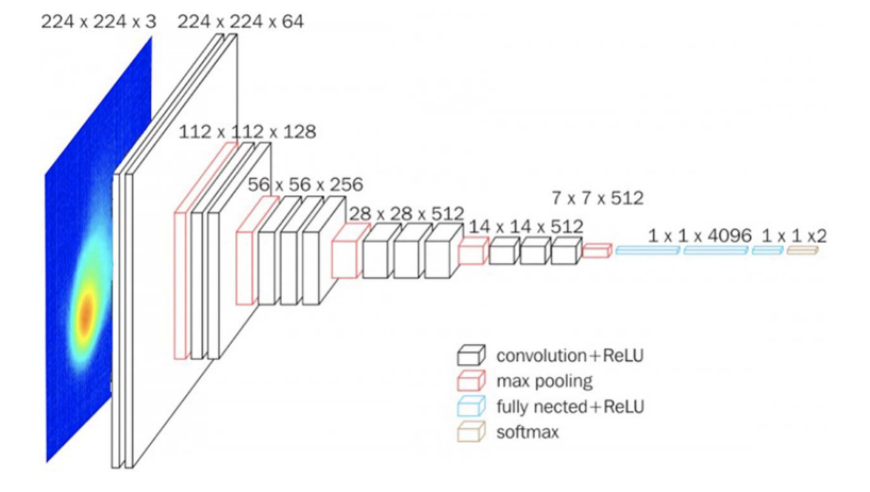
Figure 3. The VGG16 architecture modified for the PyroNet